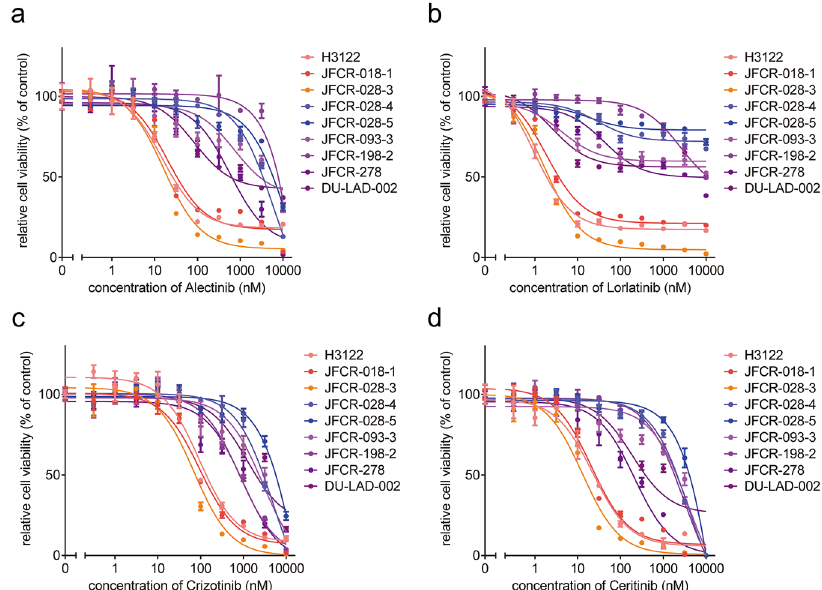
Fig. 4 Alectinib-failure PDCs were resistant to multiple ALK-TKIs. Cell viability of ALK-positive PDCs treated with the indicated concentration of a alectinib, b lorlatinib, c crizotinib, and d ceritinib for 72 h was measured ( n = 3). Each point represents the mean ± SD of three